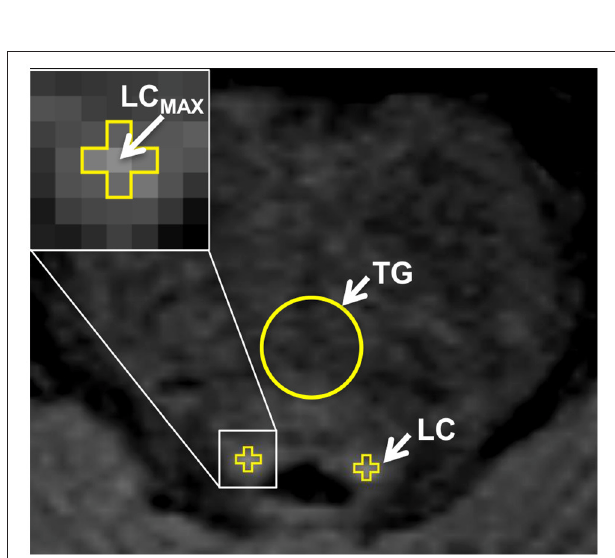
FIGURE 3 | Definition of the region of interest (ROI) for the locus coeruleus (LC) in the neuromelanin-MRI images involved identifying the highest intensity voxel adjacent to the fourth ventricle (LC MAX ), which together with its four adjacent voxels were then used to calculate LC signal intensity. The circular reference ROI in the pontine tegmentum is also